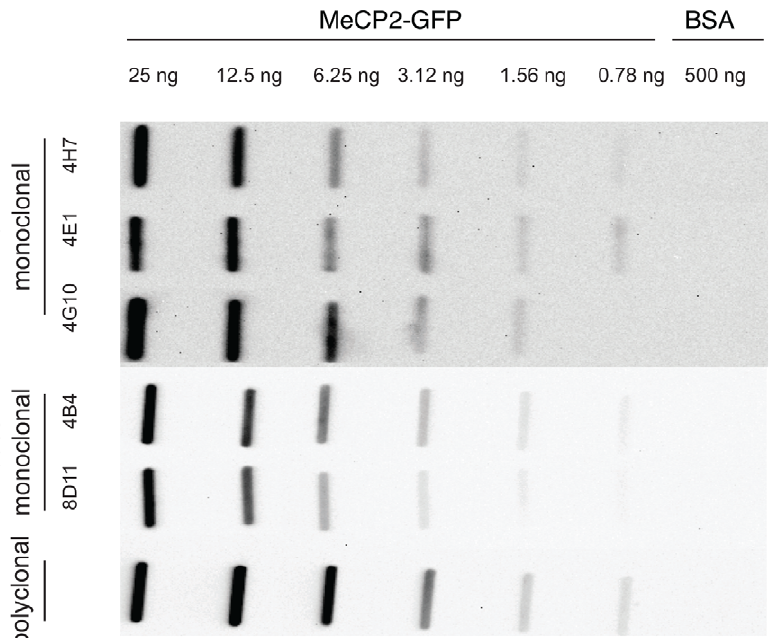
Figure 2. Antibody sensitivity. The detection limit of the MeCP2 antibodies was tested on native rat MeCP2-GFP by slot blotting analysis and lies between 1.58 and 0.78 ng of recombinant purified rat MeCP2.